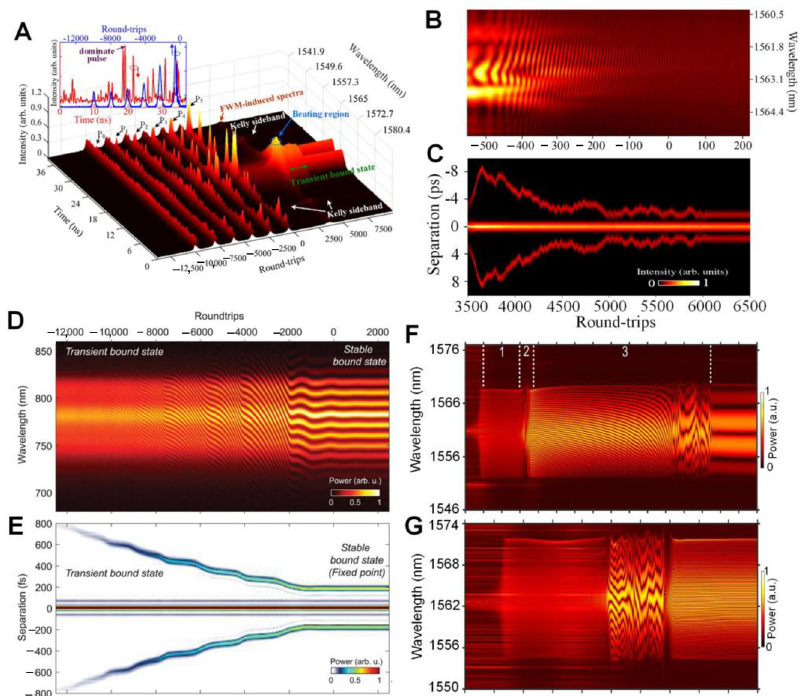
Figure 13: Various formation and